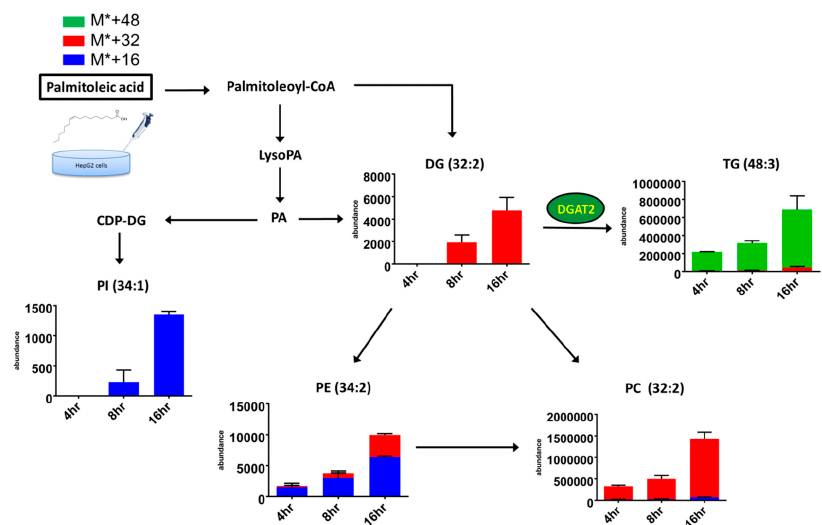
Figure 5. Metabolic pathways of and dynamic changes in lipid classes in HepG2 cells incubated for 4, 8, and 16 h with 0.3 mM 13 C16-palmitic acid. The cellular abundances of metabolites labeled with the stable isotope were marked as blue (M* + 16), and red (M* + 32) bar charts. (mean ± SD, n = 18, triplicates).